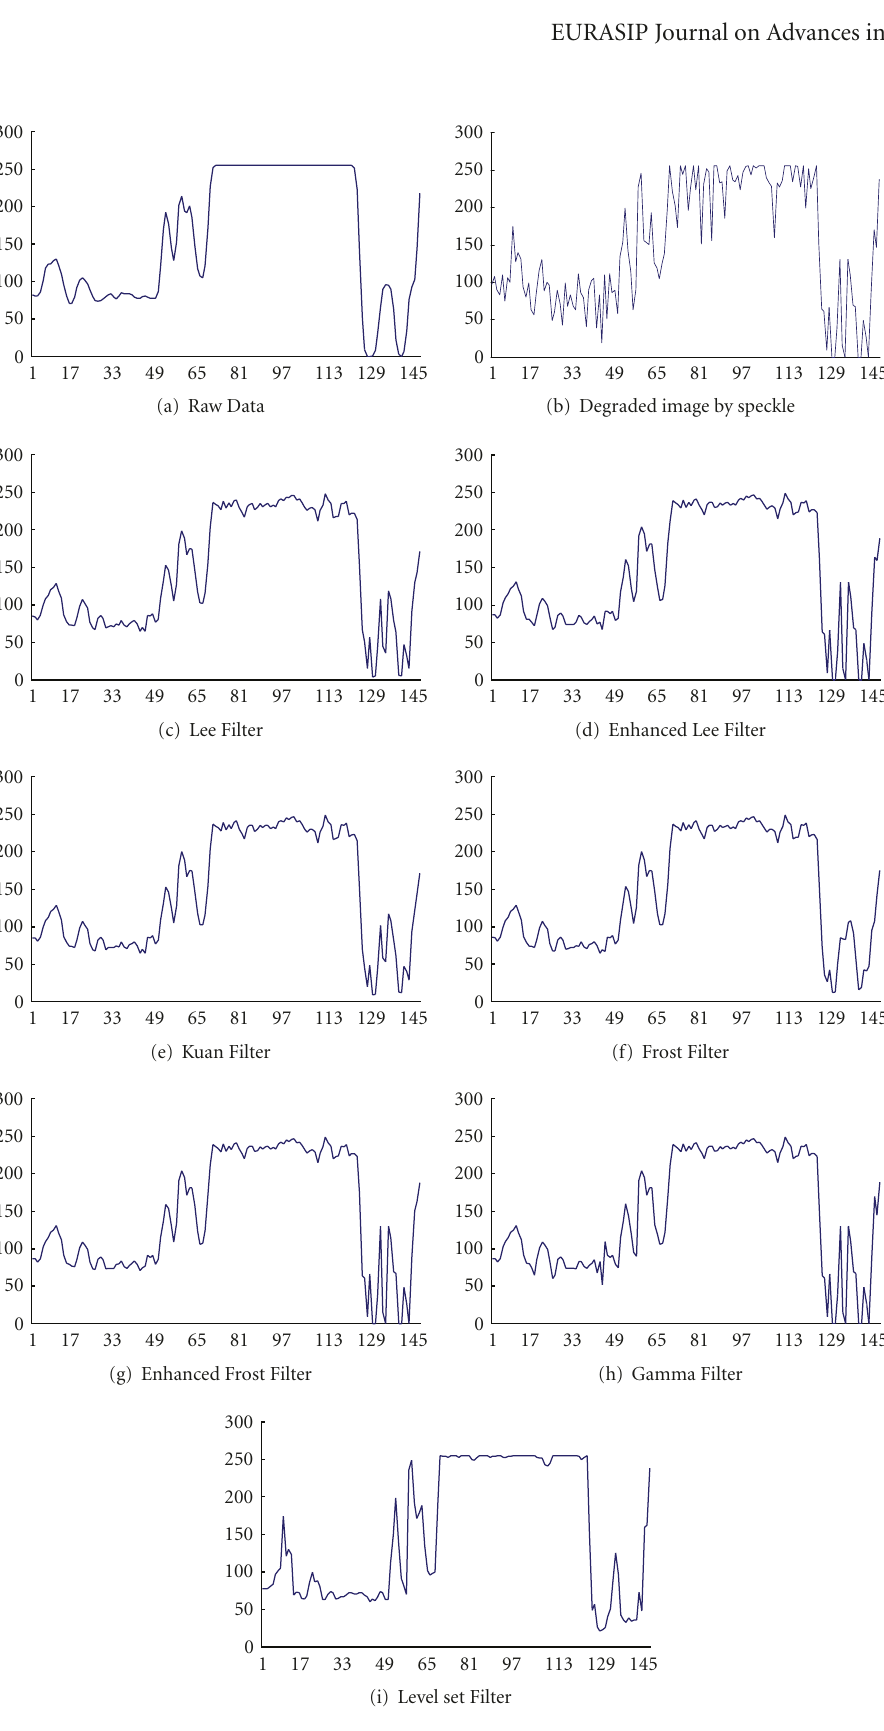
Figure 3: The profiles of Region C resulted from the proposed level set-based filter and conventional